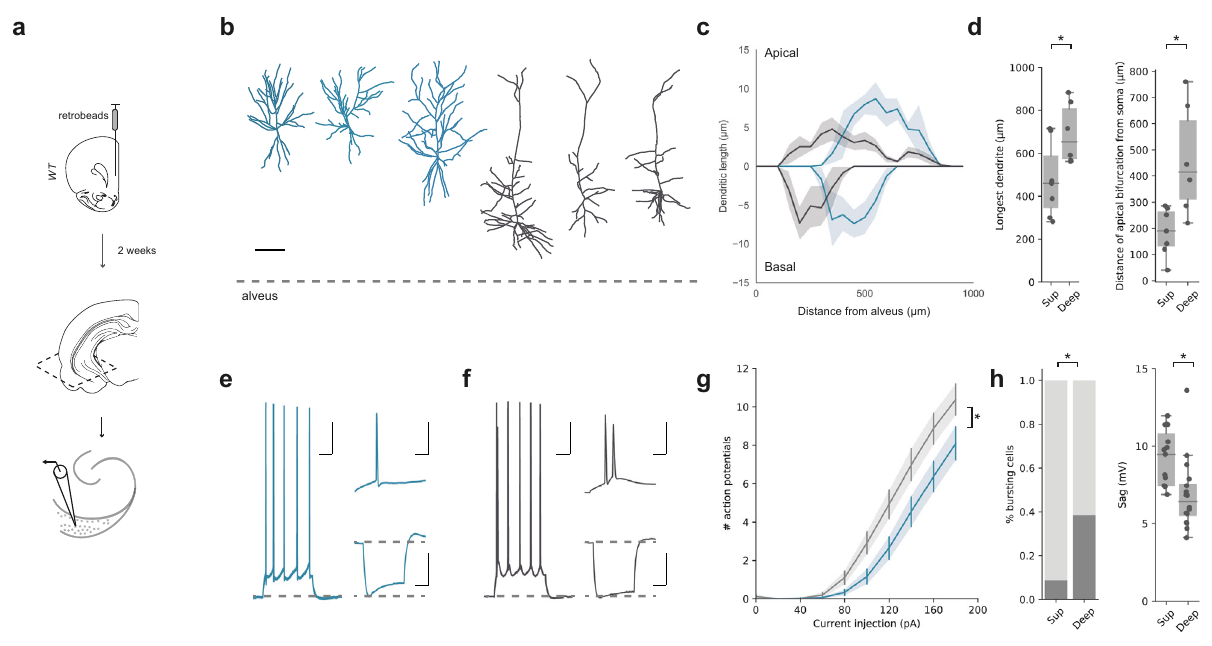
Fig. 2 Super fi cial and deep vH-PFC neurons have distinct electrophysiological and morphological properties. a Schematic of fl uorescent bead (retrobeads) injection into PFC and retrograde labelling in transverse hippocampal slices prepared for recordings. b Example reconstructions of super fi cial (blue) and deep (dark grey) PFC-projecting hippocampal neurons. Scale bar = 100 µ m, dotted line represents alveus. Images representative of 7 super fi cial and 6 deep neurons. c Sholl analysis showing average dendritic length of apical (top) and basal (bottom) dendrites with increasing distance from the alveus (lateral) for super fi cial (blue) and deep (grey) layer vH-PFC neurons. Note that each population samples a distinct range of the radial hippocampal axis. (Apical: repeated measures ANOVA, Main effect of group: F (35,385) = 1.549, p = 0.027; basal: repeated measures ANOVA with Greenhouse-Geisser correction, Main effect of group: F (33,367) = 1.701, p = 0.179; n = 7 (super fi cial), n = 6 (deep) neurons from 6 mice). d Left, quanti fi cation of the distance from the farthest dendrite tip to the soma (two-sided Mann Whitney, U = 35.5, * p = 0.045). Right, quanti fi cation of the distance of the apical bifurcation from the soma in super fi cial (Sup) and Deep neurons (two-sided Mann Whitney, U = 38.5, * p = 0.015, n = 7 (super fi cial), n = 6 (deep) neurons from 6 mice). e Left, example response of a super fi cial layer PFC-projecting cell in response to a current injection of 140 pA. Top right, detail of fi rst 50 ms of current injection. Bottom right, response to a current injection of – 160 pA. Scale bars = 100 ms, 20 mV; 10 ms, 20 mV; 100 ms, 20 mV. f As in ( e ) but for a neighboring deep layer PFC-projecting neuron. Note burst fi ring in response to current injection, and lower level of voltage sag after negative current injection. g Quanti fi cation of number of action potentials elicited by somatic current injection in super fi cial (blue) and deep (black) neurons (Repeated measures ANOVA with Greenhouse-Geisser correction, Interaction between group and current step: F (1.4, 44.5) = 4.3, * p = 0.032, n = 22 (sup) and 26 (deep) from 12 mice). h Left, quanti fi cation of the proportion of bursting neurons after positive current injections (Fishers Exact test, Odds ratio = 12.5, * p = 0.009). Right, quanti fi cation of sag amplitude after negative ( – 160 pA) current injections (two-sided Mann Whitney, U = 39.5, * p = 0.002, n = 22 (sup) and 26 (deep) from 12 mice). Box plots show median, 75th (box) and 95th (whiskers) percentile. Line plots show mean (line) and SEM (shading and error